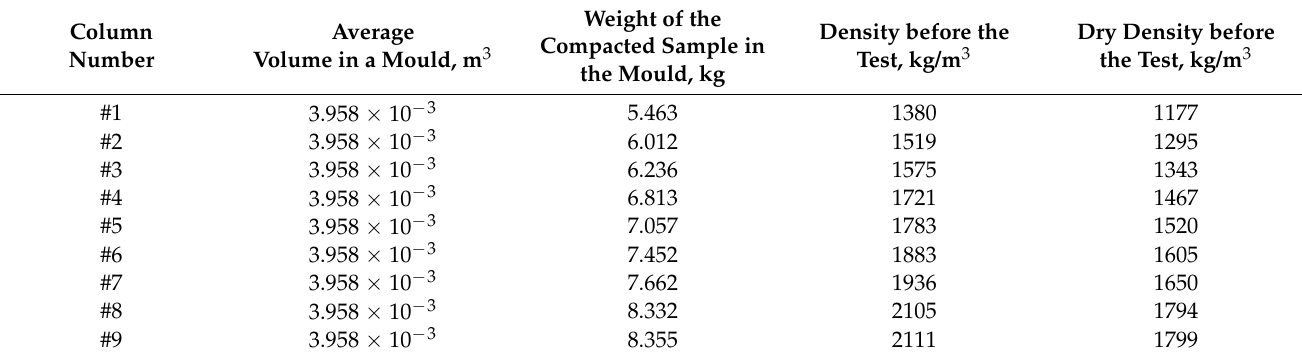
Table 1. Initial density distribution within the soil samples.